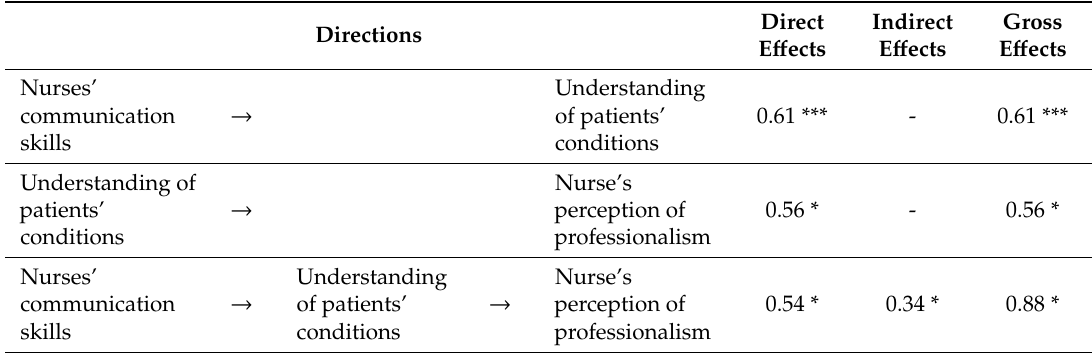
Table 6. Mediating e ff ect